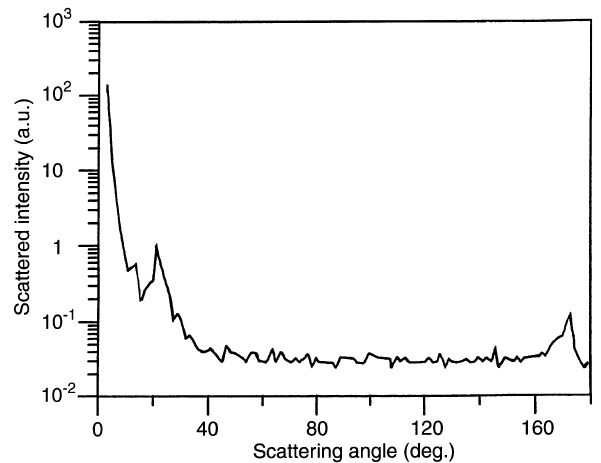
Fig. 12. Scattered intensity for the fourth 30-s interval of Fig. 8